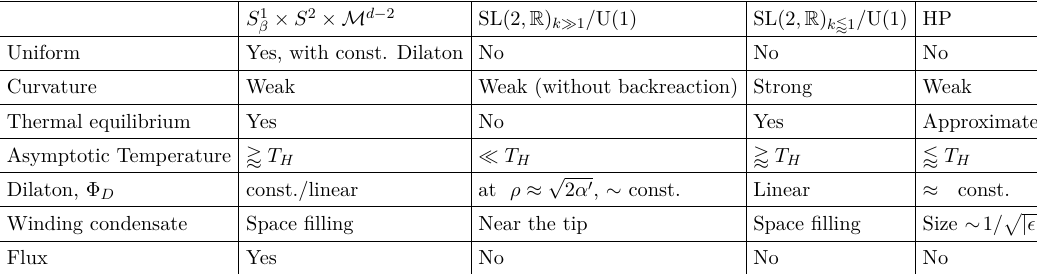
Table 1 . In this table, we list the similarities and differences between the various target spaces, the S 1 × S 2 ×M d − 2 background, the cigar background, the super-Liouville one and the HP β